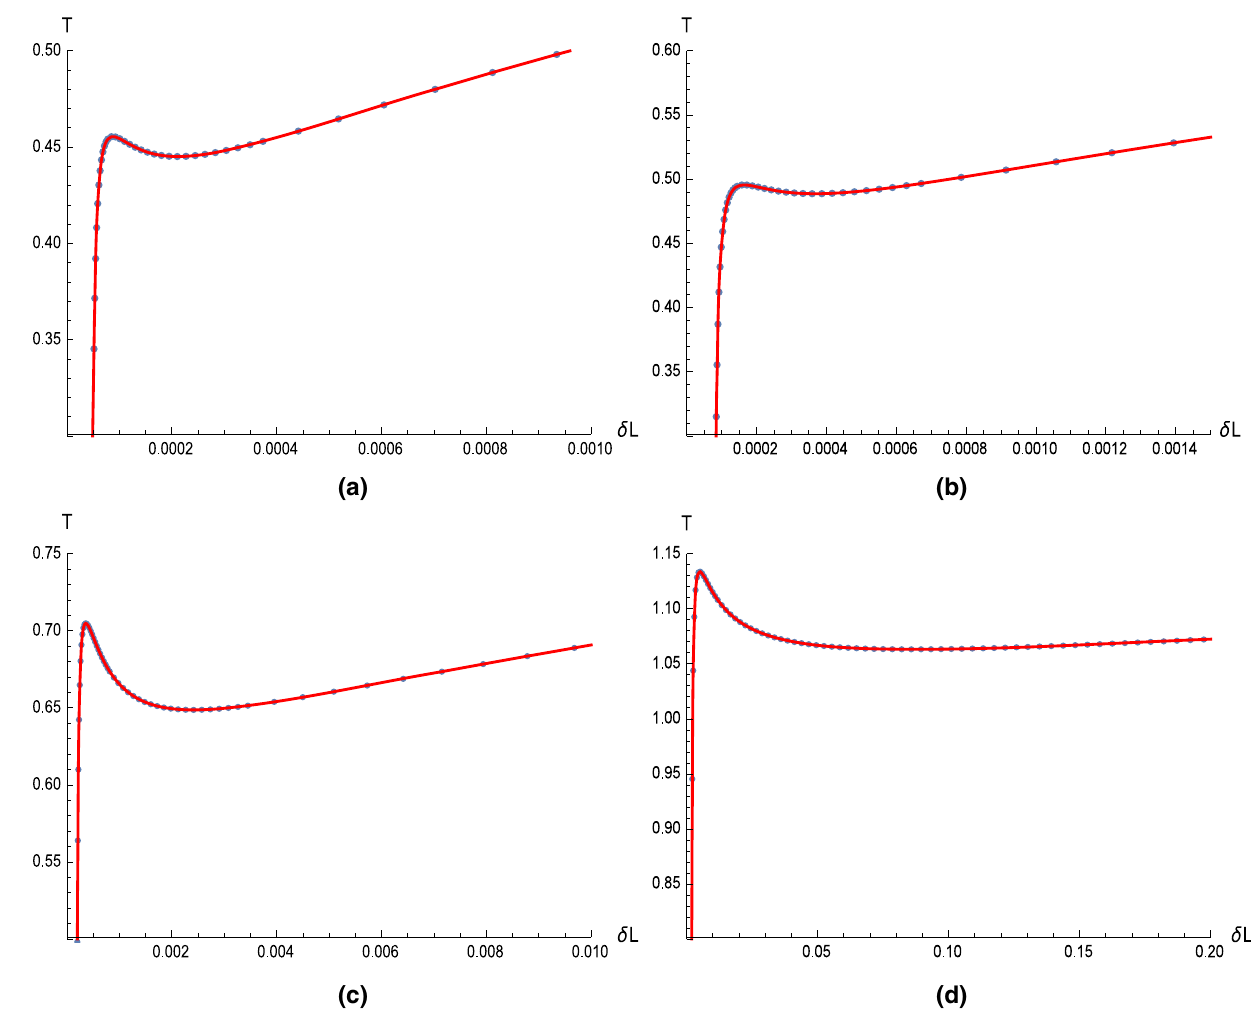
Fig. 2 T vs. δ L for n = 4 ,θ 0 = 0 . 2. a α = 0 , q = 0 . 12, b α = 0 . 25 , q = 0 . 12, c α = 0 . 5 , q = 0 . 06, d α = 0 . 75 , q = 0 . 06